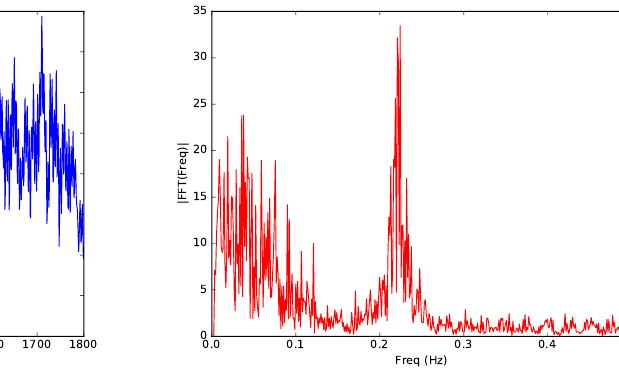
Figure 8. The time-series of the lift force on the cylinder is shown in ( a ), with the FFT of lift in ( b ) showing a pronounced peak at about 0.22–0.225